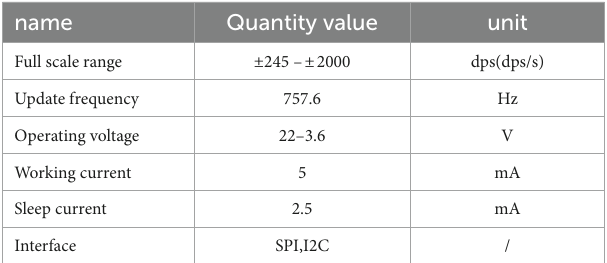
TABLE 3 Main performance indicators of the gyro chip